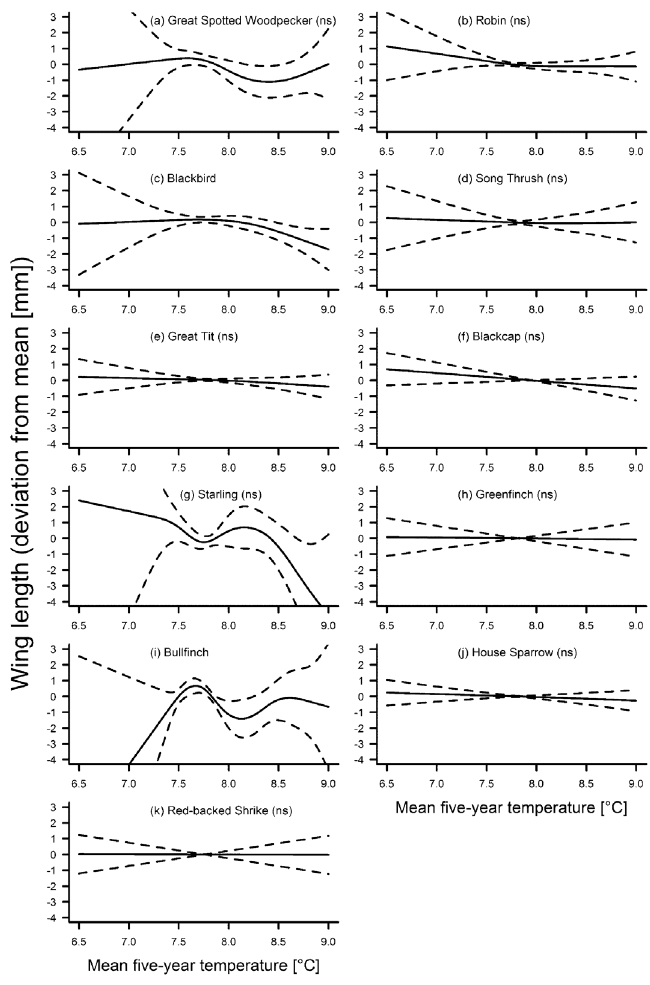
Figure 3. Fluctuations in wing length of eleven bird species in association with the five-year mean annual temperature. Solid line – regression spline fit from the GAM; dashed lines – 95% confidence intervals. See methods for details. A p-value of . 0.05 is indicated with (ns) after the species name, see table 3 for exact p-values.